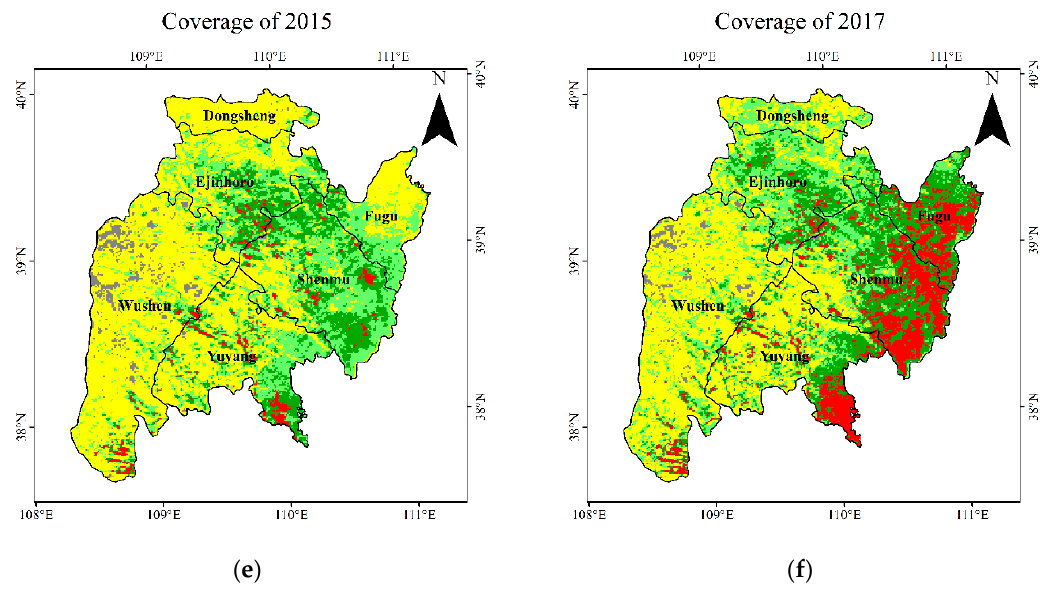
Figure 2. Changes in vegetation coverage (VC) in six counties (Shenmu, Ejin Horo Banner, Yuyang District, Wushen, Dongsheng District, and Fugu) from 2000 to 2017. ( a ) is the vegetation coverage in six counties in 2000; ( b ) is the vegetation coverage in six counties in 2005; ( c ) is the vegetation coverage in six counties in 2008; ( d ) is the vegetation coverage in six counties in 2010; ( e ) is the vegetation coverage in six counties in 2015; ( f ) is the vegetation coverage in six counties in 2017.